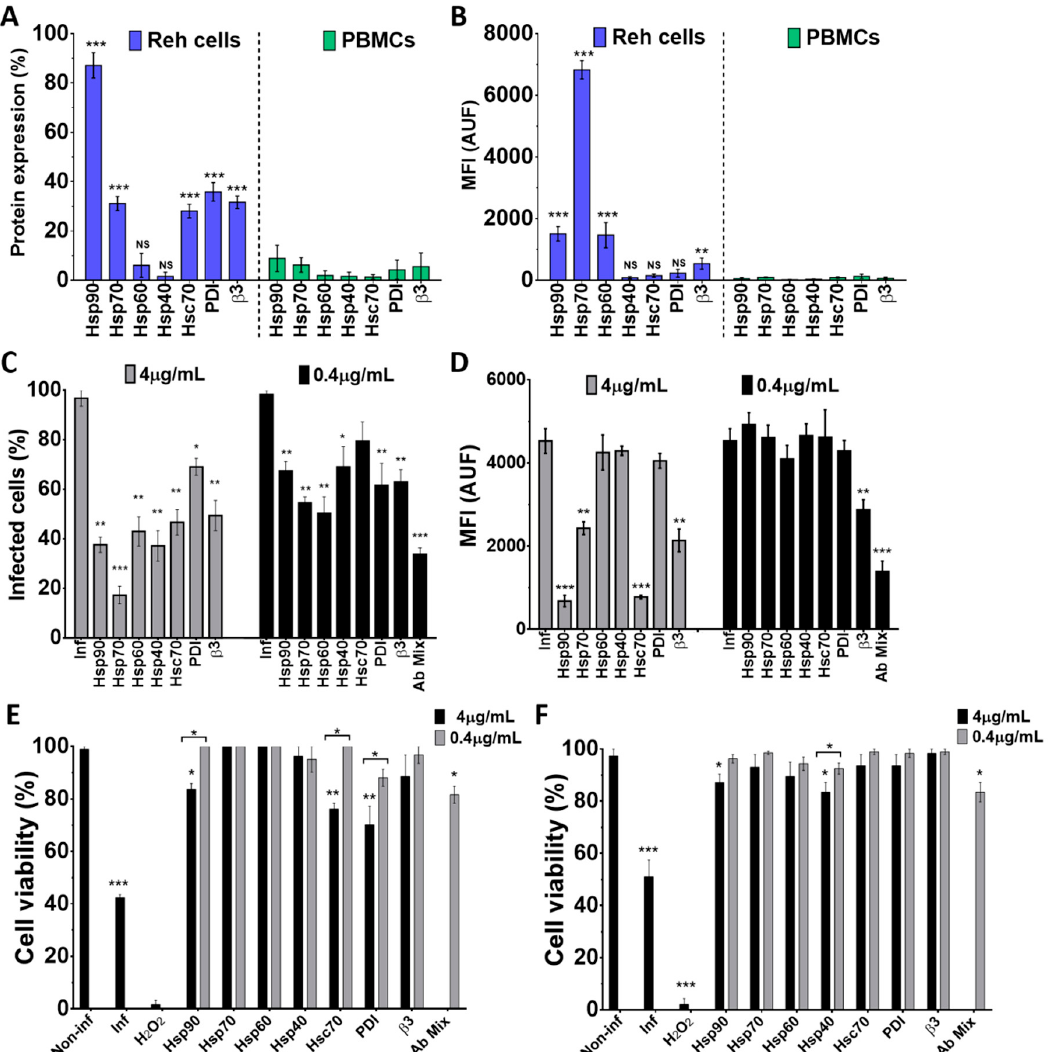
Figure 6. Inhibition of Wt1-5 infection after pre-treatment of Reh cells with antibodies to HSPs, Hsc70, PDI and integrin β 3. Reh cells and PBMCs were treated with antibodies to Hsp90, Hsp70, Hsp60, Hsp40, Hsc70, PDI and integrin β 3 and labeled with secondary antibodies labeled with FITC, and then, subjected to flow cytometric analysis. ( A ) Flow cytometry analysis for each cellular protein of Reh cells and PBMCs is shown. ( B ) Median fluorescence intensity (MFI) for each cellular protein of Reh cells and PBMCs is shown. Isotype antibodies were used to adjust quadrants. Results are from three di ff erent assays. ( C ) Reh cells at a logarithmic growth phase were pre-treated with antibodies (4 or 0.4 mg / mL) to cellular proteins Hsp90, Hsp70, Hsp60, Hsp40, Hsc70, PDI and integrin β 3 for 1 h at 37 ◦ C. After removal of antibodies, cells were infected with trypsin-activated Wt1-5 at MOI 2 and harvested at 24 h.p.i. before PFD fixation and permeabilization. Viral structural antigens were analyzed by flow cytometry for each antibody treatment using control isotype antibodies to adjust quadrants. Percentages of Wt1-5-infected cells are shown. ( D ) Median fluorescence intensity (MFI) quantification in terms of arbitrary units of fluorescence (AUF) is shown for viral structural proteins for each antibody treatment described in ( C ). ( E ) Cell viability was assessed with the resazurin reduction test for cells that had previously been treated with antibodies to each cellular protein (Hsp90, 7Hsp0, Hsp60, Hsp40, Hsc70, PDI and integrin β 3). Wt1-5 infected cells and non-infected and non-antibody-treated cells were used as a control at 24 h.p.i. ( F ) Cell viability of an aliquot of cells assayed in ( E ) but determined with the trypan blue exclusion test is shown. Data are shown as mean ± SD of three independent experiments performed in duplicate. Statistical significance is indicated by p -values (*** p ≤ 0.01, ** p ≤ 0.05, and * p ≤